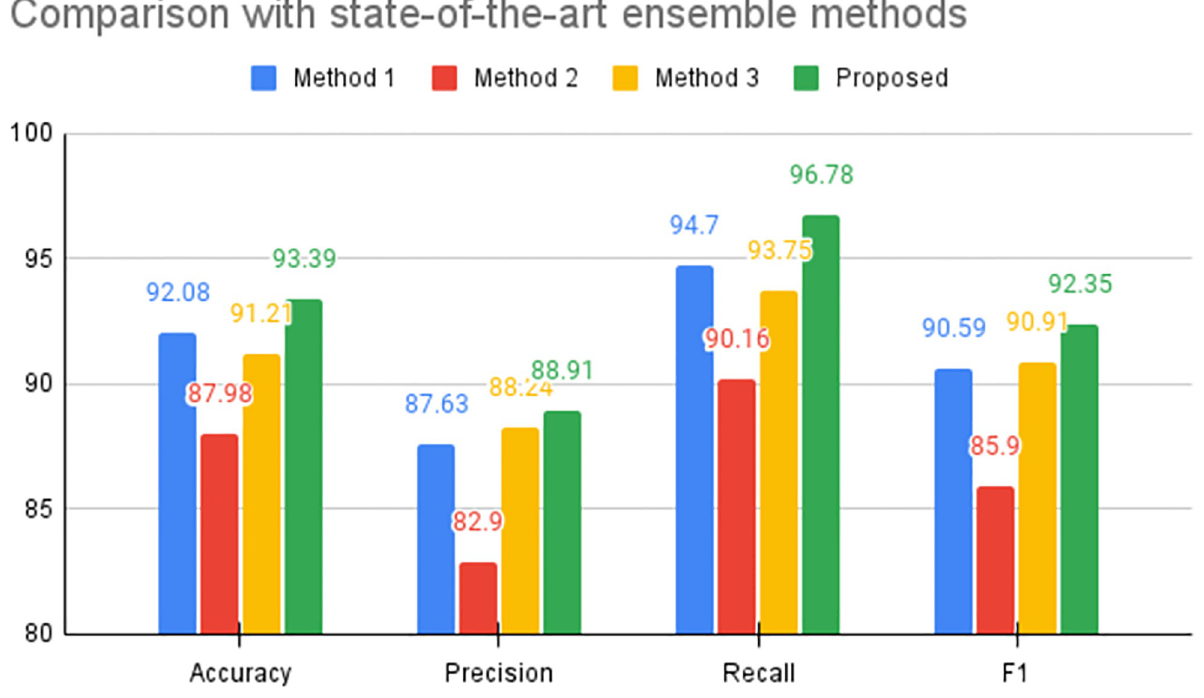
Fig 9. Performance comparison of the proposed method with state-of-the-art ensemble techniques. Here, Method 1 refers to the work reported in [22], Method 2 refers to the work reported in [32] and Method 3 refers to the work reported in [33]. Furthermore, the values presented are averaged across all 5 folds of the experiments. The reported scores are in (%).